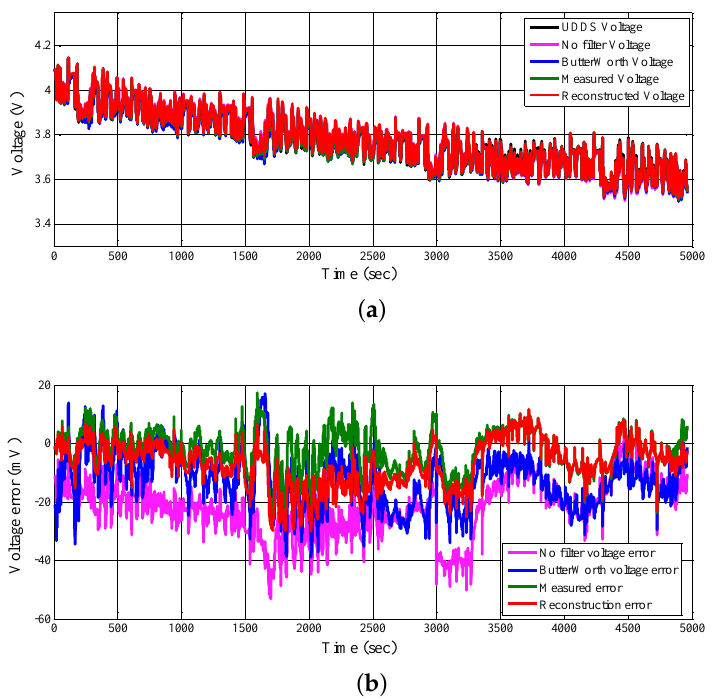
Figure 11. Simulated voltage results and errors under UDDS test at 40 ◦ C. ( a ) Comparison of the UDDS voltage and simulated voltages under UDDS test. ( b ) Simulated voltage errors with different methods under UDDS